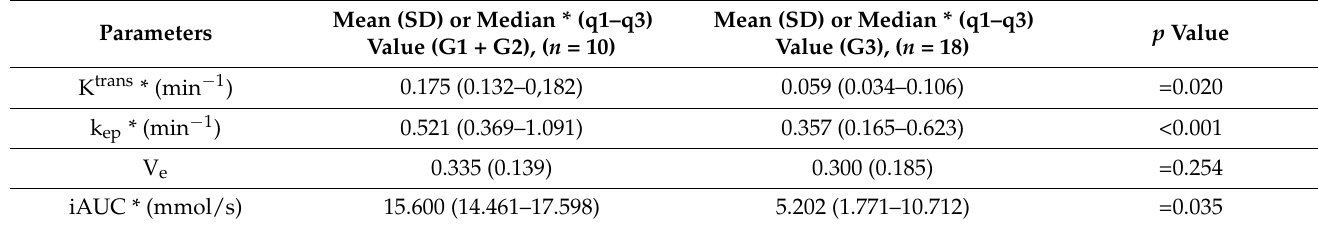
Table 5. DCE-MRI perfusion parameters in different grades of PDAC.